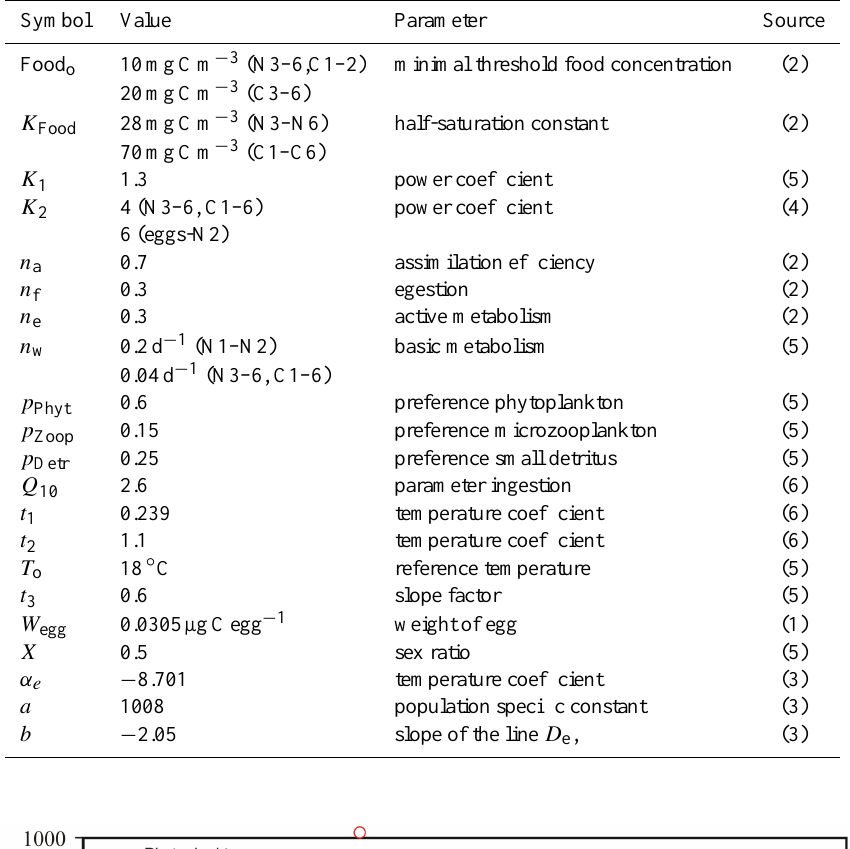
Table 1. Parameter values for Acartia spp. in the presented model. Source: (1) Ambler (1985), (2) Dzierzbicka-Glowacka et al. (2009), (3) Norrbin (1996), (4) Stegert et al. (2007), (5) in this paper and (6) see Fig. 3 in this paper.